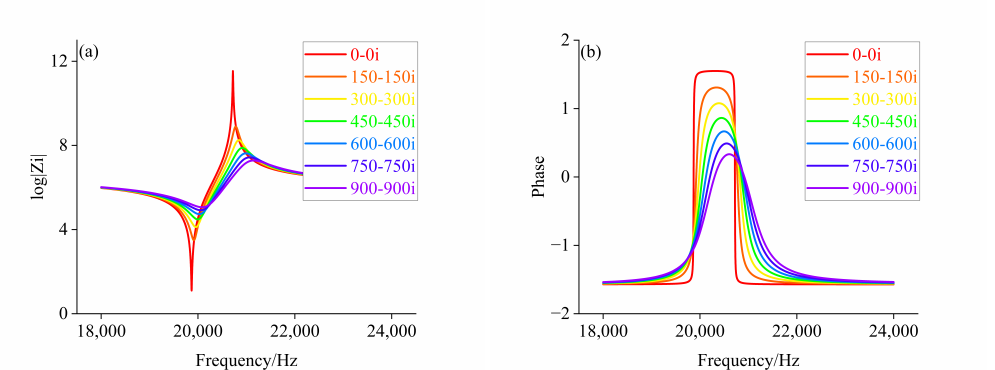
Figure 8. ( a ) Amplitude value characteristics when Z ft is a capacitive load; ( b ) Phase frequency characteristics when Z ft is a capacitive